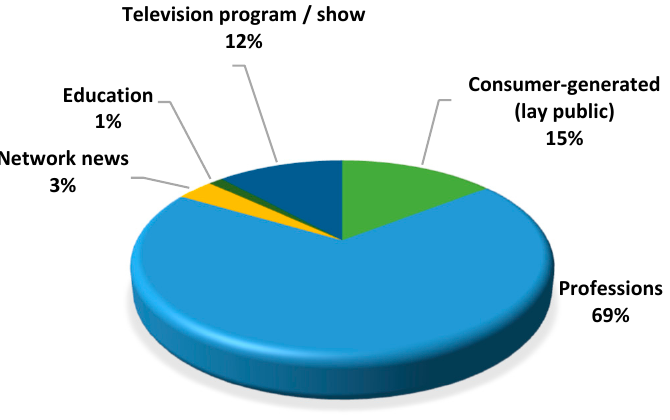
Figure 3. Source of videos on dental fear, dental anxiety, and dental phobia.